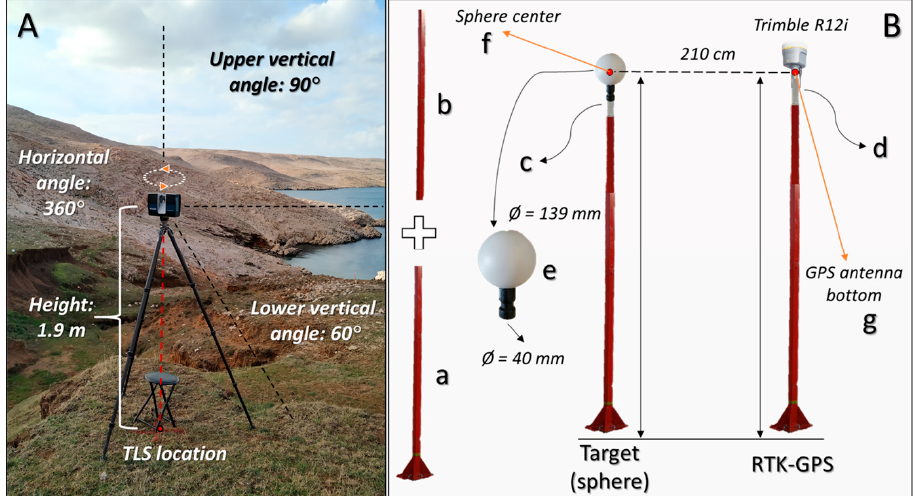
Figure 3. Faro Focus M70 terrestrial laser scanner used for multi-temporal point cloud acquisition ( A ); Design of metal poles for mounting of permanent survey targets ( spheres ) to the preferred height ( B ) (a & b— metal poles ; c— adapter for sphere ; d— adapter for RTK-GPS antenna ; e— standard sphere ; f— sphere center ; g— RTK-GPS antenna bottom ).